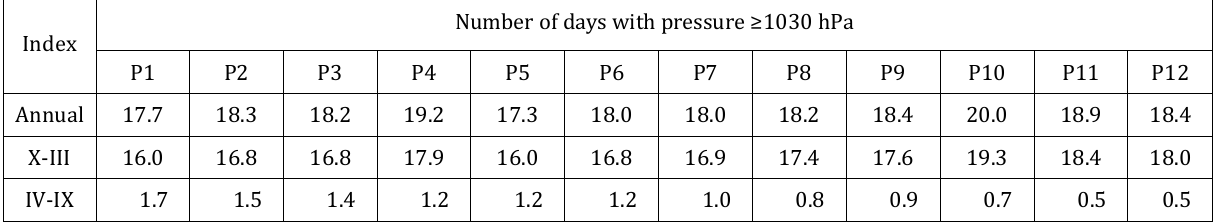
Table 3. Average number of days with air pressure equal to or higher than 1030 hPa (SHP days) at selected grid points